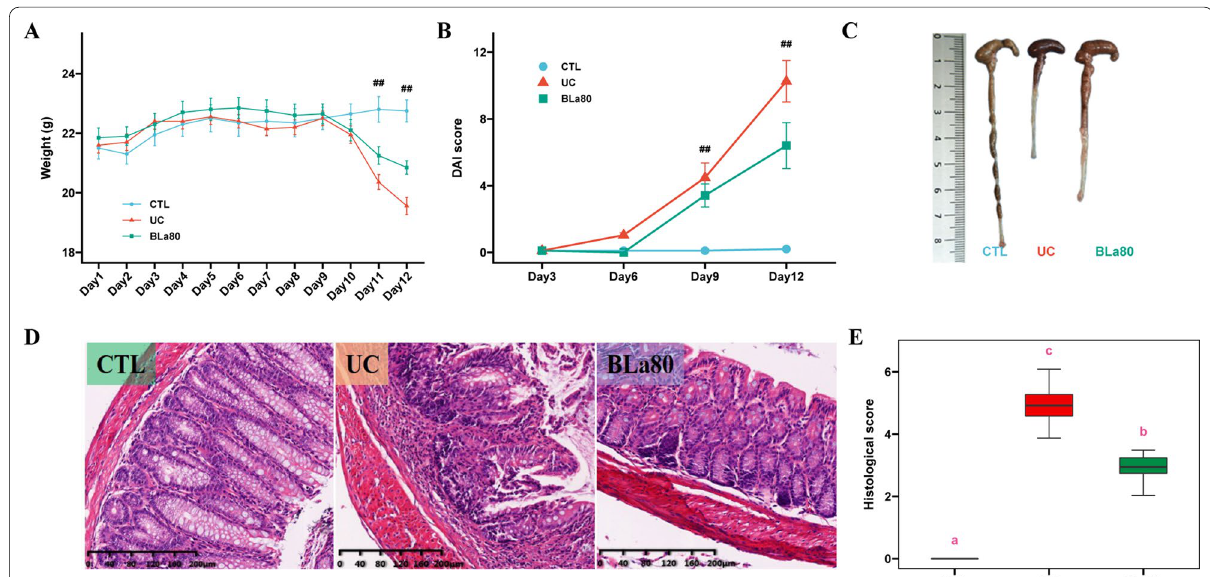
Fig. 1 Effect of BLa80 on body weight, DAI, colon length and distal colon tissue in UC mice. BLa80 significantly improved UC physiological parameters in mice: A body weight change in mice; B DAI assessment of UC in mice; the above data were characterized as mean deviation (SD). C Macroscopic picture of colon length; D Pathological examination of colon tissue (scalebar